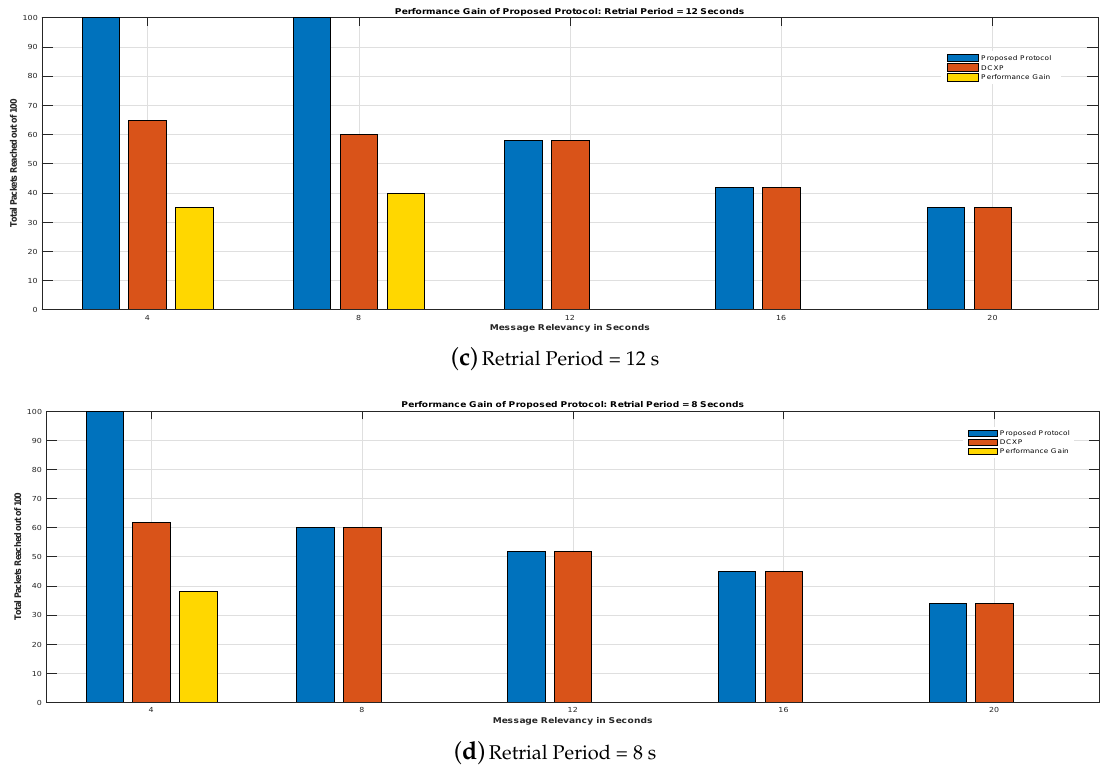
Figure 8. Bar Chart illustrating Packet Loss in the Proposed Protocol and DCXP. ( a ) Retrial Period = 20 s; ( b ) Retrial Period = 16 s; ( c ) Retrial Period = 12 s; ( d ) Retrial Period = 8